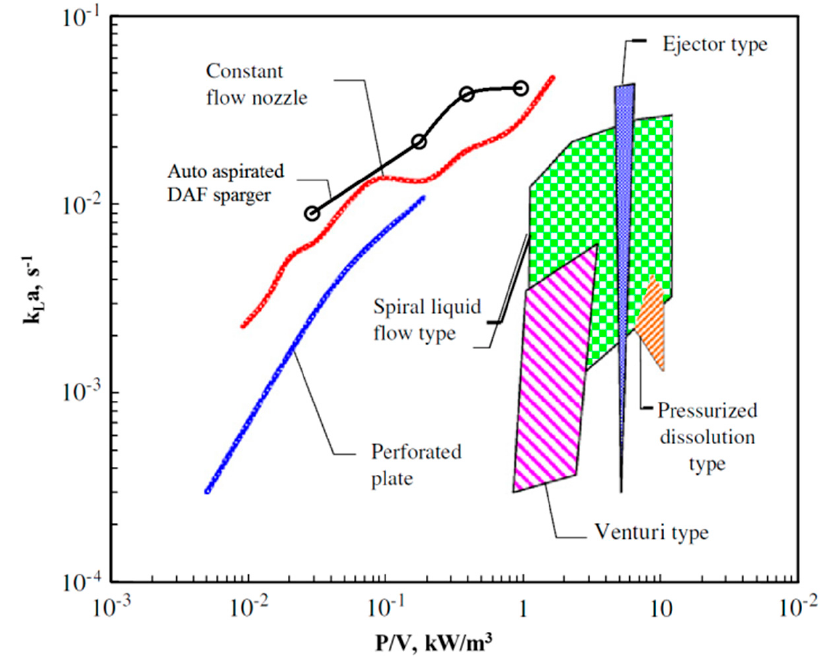
Figure 16. Specific power requirement for water aeration of various sparger types (adopted from [38]).